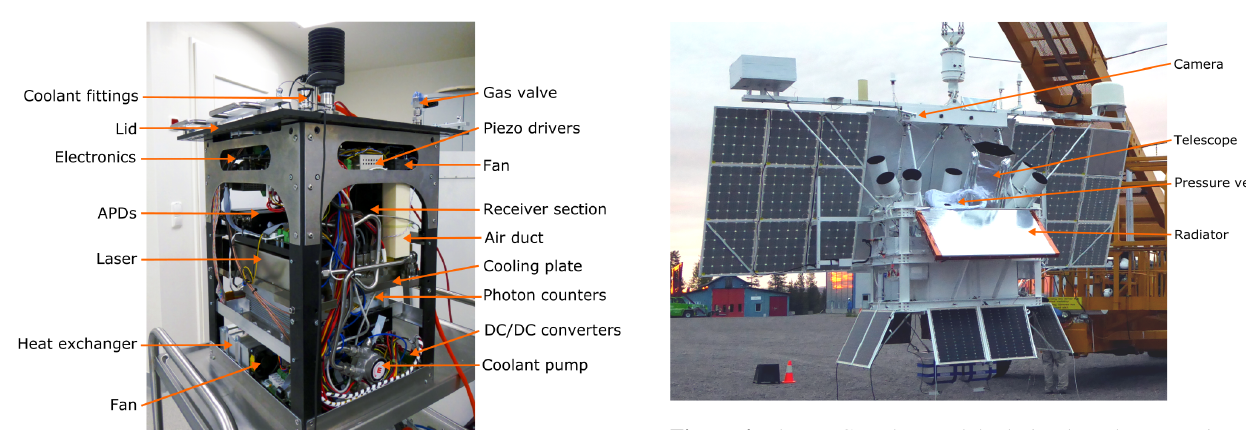
Figure 4. The PMC Turbo gondola during launch preparations on 6 July